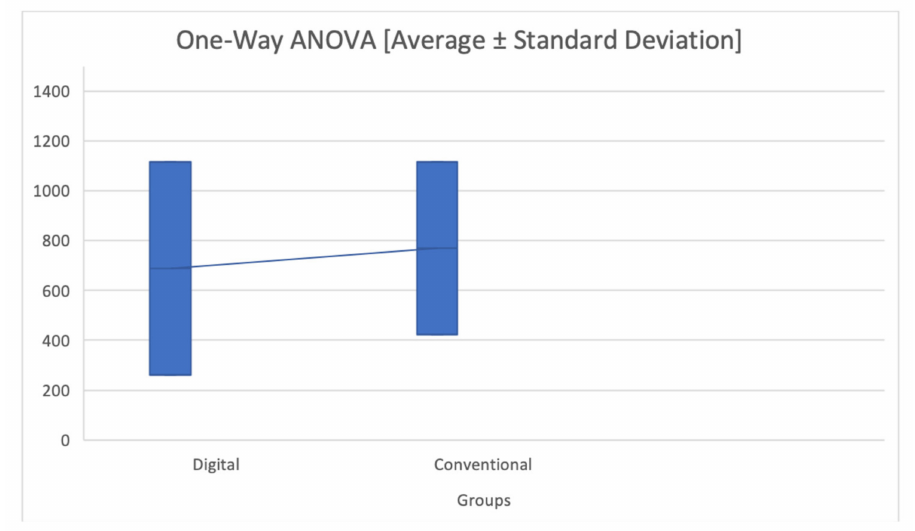
Figure 2. Analysis of Variance between digital and conventional impression techniques. Vertical axis: time in seconds; Horizontal axis: